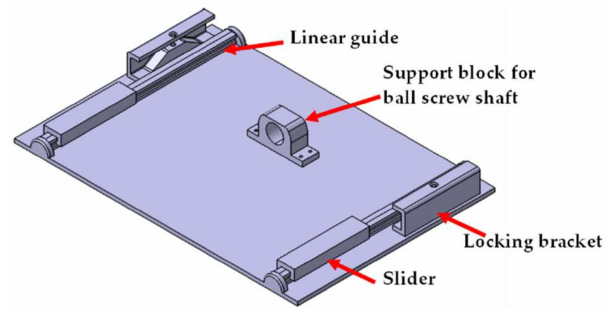
Figure 9. CAD model of base plate